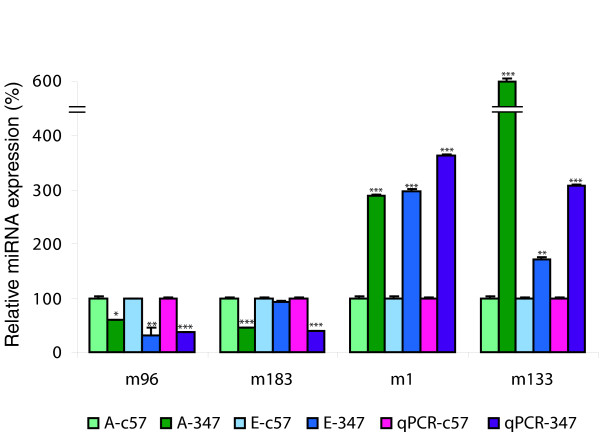
Differentially expressed miRs between c57 versus P347S retinas. Expressions of mouse microRNA (miR)-96, miR-183, miR-133 and miR-1 were analyzed using Ambion miR microarrays (green, 'A-' in legend), Exiqon miR microarrays (blue, 'E-' in legend), and quantitative real-time reverse transcription polymerase chain reaction (qPCR; magenta). Expression levels of each miR in P347S (mutant pro347ser RHO transgene; dark green, dark blue, and purple columns) versus c57 retinas (taken as 100%; light green, light blue and magenta columns) were compared. Note that the y-axis is discontinuous. *P < 0.05, **P < 0.01, and ***P < 0.001.